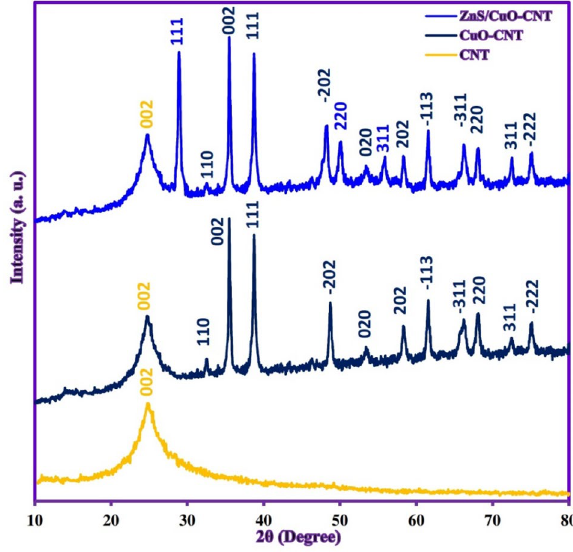
Figure 5. XRD patterns of CNT, CuO-CNT, and ZnS/CuO-CNT.